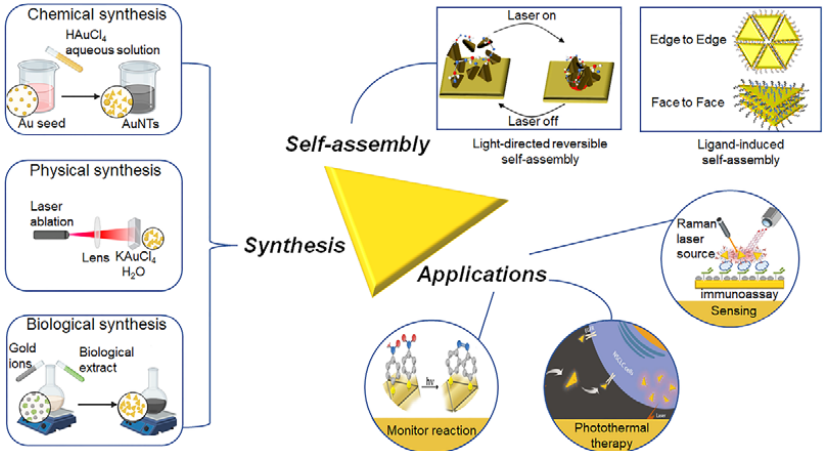
Figure 1. Schematic presentation of the main contents of this review. Synthesis, self-assembly of AuNTs and their applications. Taken with permissions from [48–50]. Adapted with permission from Ref. [48]. Copyright © 2022 American Chemical Society. Adapted with permission from Ref. [49]. Copyright © 2022 Elsevier B.V. Adapted with permission from Ref. [50]. Copyright © 2022 American Chemical Society.